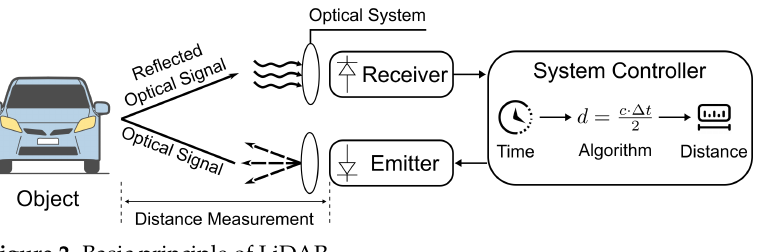
Figure 2. Basic principle of LiDAR.